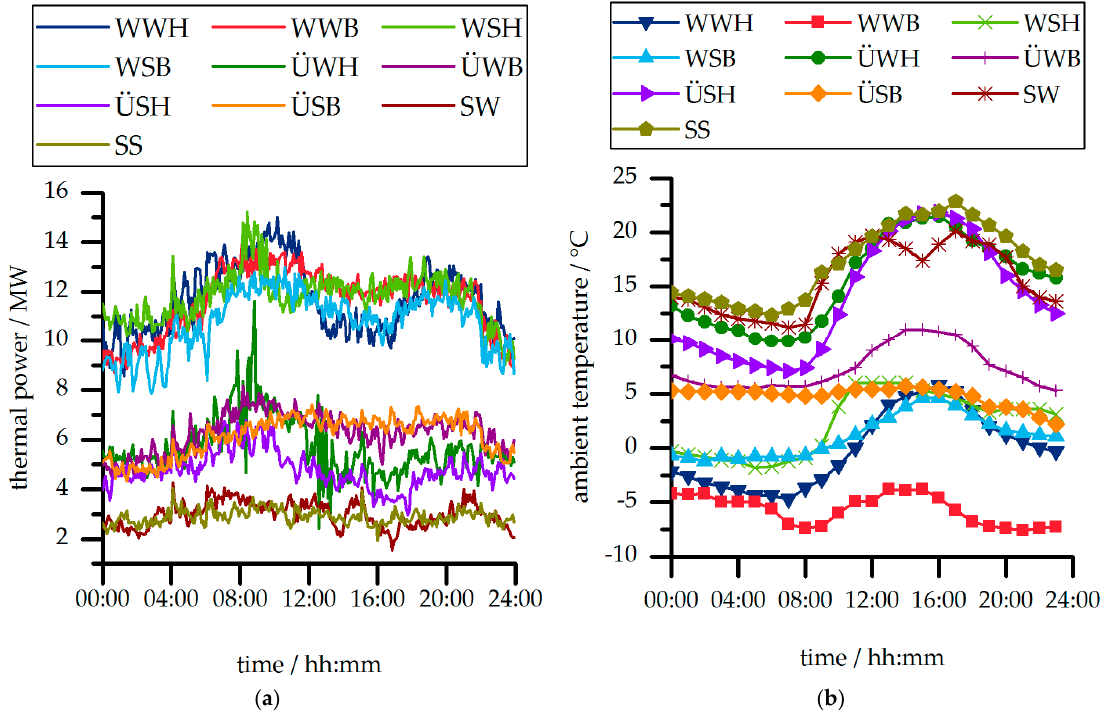
Figure 6. Reference load profiles ( a ) and ambient temperature profiles ( b ) for the typical day categories.